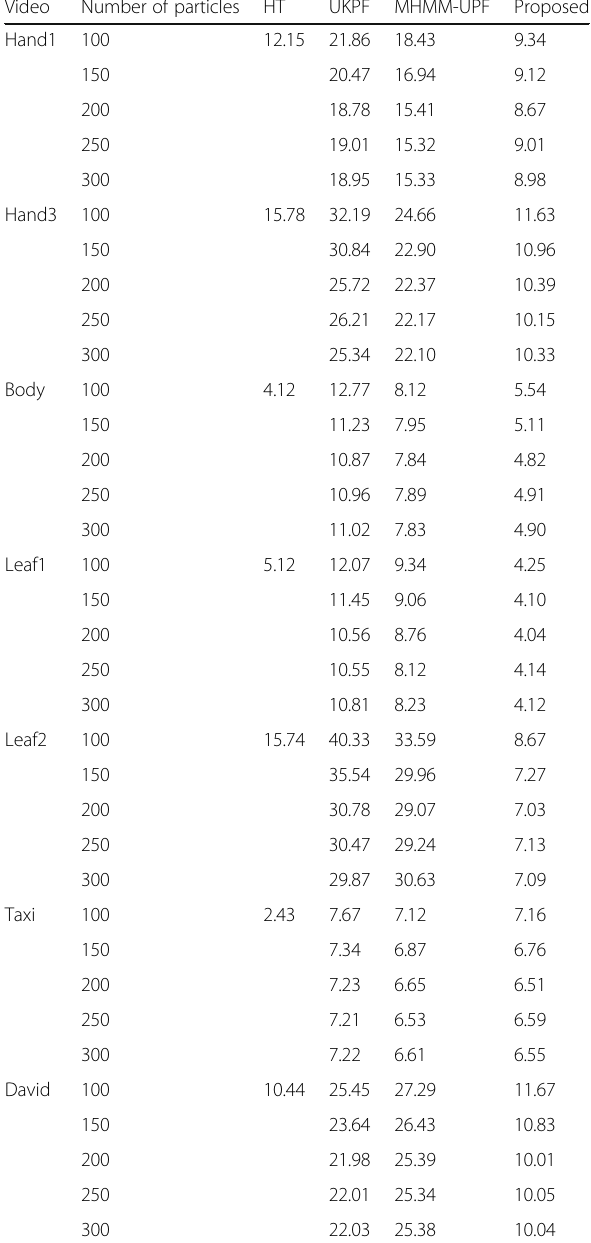
Table 3 Average Euclidean distance using different